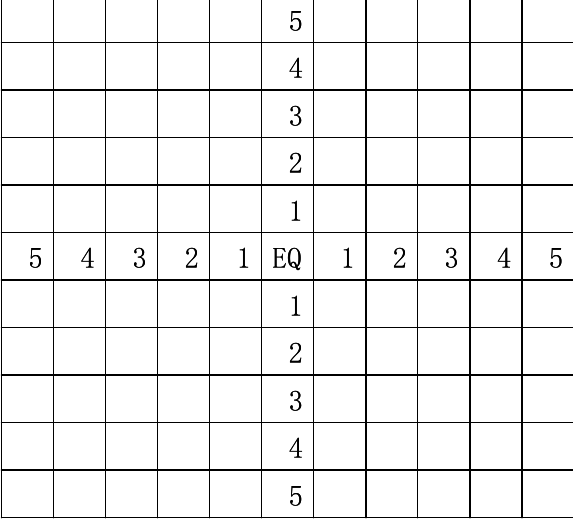
Fig. 1. Research area centre around one